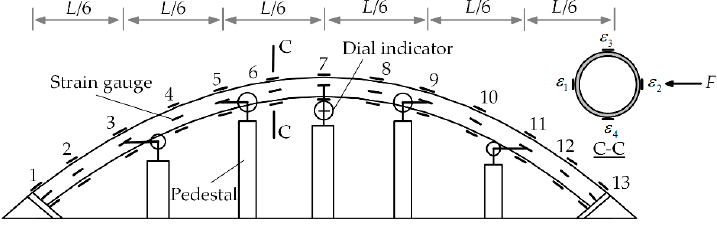
Figure 3. The measuring scheme of arch-B.